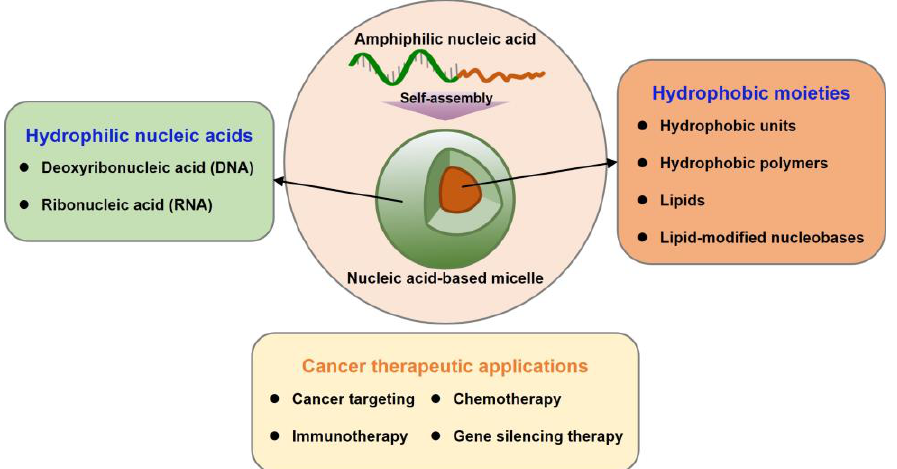
Figure 2. Outline of this review dealing with nucleic acid micelles.